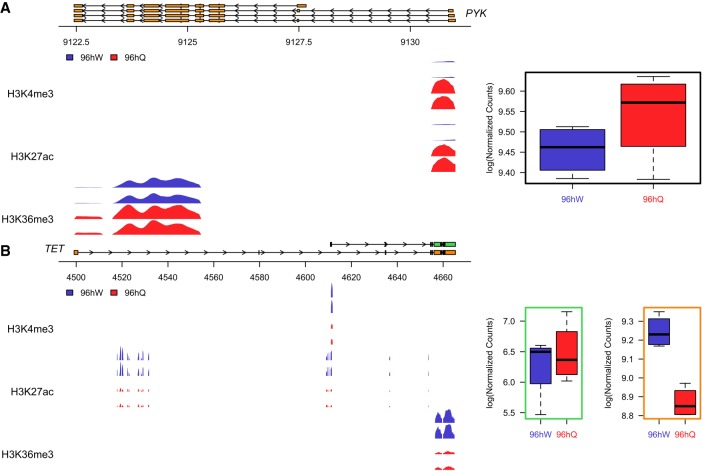
Profiles of two genes that show a significant difference in both ChIP-seq enrichment and transcript expression between castes. (A) Pyruvate kinase (PYK; LOC552007). Regions are shown which reach genome-wide significance (P ≤ 0.01) and have a greater than threefold difference in enrichment over input between 96hW (blue) and 96hQ (red). The expression profile is shown in the right panel. (B) Ten-eleven translocation (TET; LOC412878). Regions are shown which reach genome-wide significance (P ≤ 0.01) and have a greater than threefold difference in enrichment over input between 96hW (blue) and 96hQ (red) for both TET transcripts, XM_016915488 (upper transcript) and XM_006561197 (lower transcript). The expression profile is also shown for transcripts XM_016915488 (left) and XM_006561197 (right).